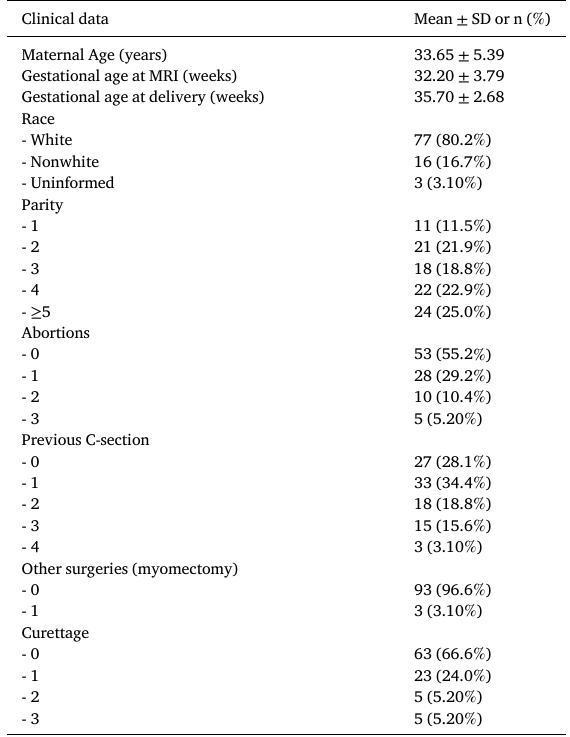
Table 1 Characteristics of study subjects.